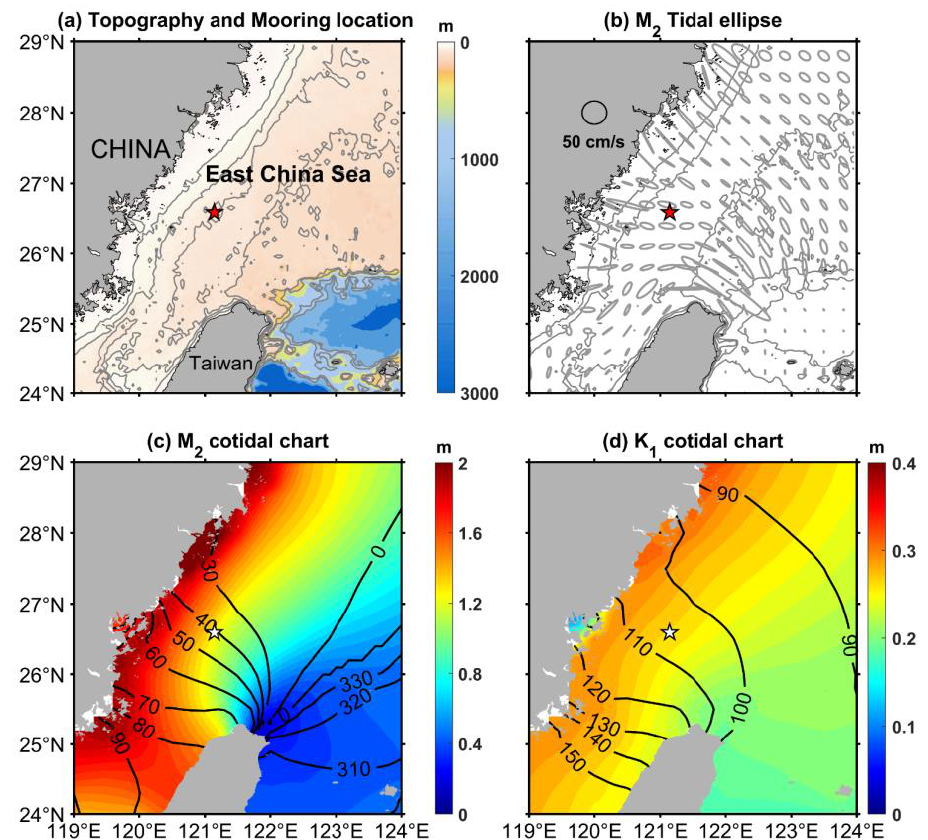
Figure 1. ( a ) Bathymetry for the East China Sea Shelf (color), with the mooring location (red star). The solid gray lines indicate the isobathic contours of 30, 50, 70, 100, 200, 800, and 1000 m (Smith and Sandwell 1/60° by 1/60°). ( b ) M 2 tidal ellipse obtained from TPXO 7.2. Tidal ellipses (with major axes scaled to unit) are shown in gray at a grid spacing of 0.3° by 0.3°. The contours are the isobaths of 30, 50, 100, 200, and 1000 m. ( c ) M 2 cotidal chart based on TPXO 7.2. The contours indicate the co-phase lines with interval of 10°, except at 330°, 0°, and 30° with interval of 30°. ( d ) K 1 cotidal chart based on TPXO 7.2.